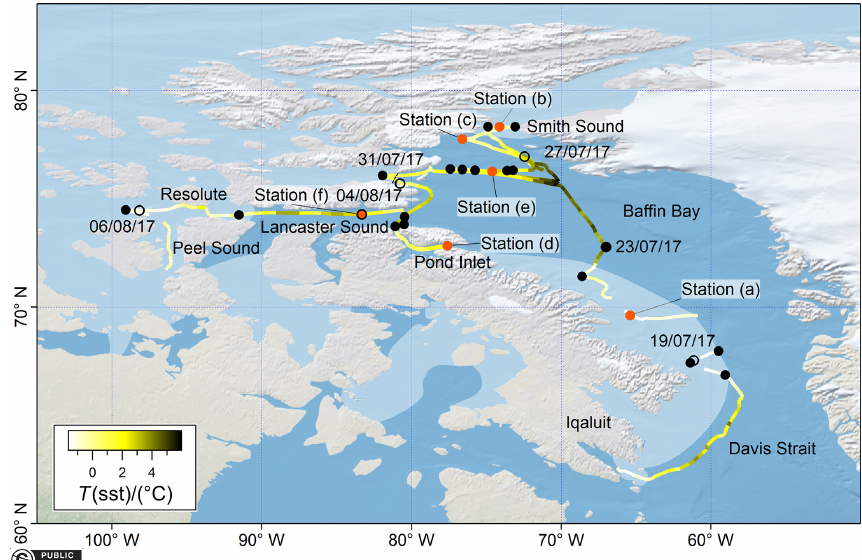
Figure 1. Cruise track of the sampling undertaken in the Arctic sea ice zone coloured by sea surface temperature (SST). Sampling dates are indicated as hollow circles marked with the date. The location of each CTD station where sampling was undertaken is indicated as a closed black dot. Highlighted CTD stations are indicated as closed orange dots and labelled by station number. Interruptions in the cruise track and underway auxiliary data are due to interruptions in the ship underway logging system (Amundsen Science Data Collection, 2017). All the map data were created from public domain GIS data found on the Natural Earth website (http://www.naturalearthdata.com, last access: 15 April 2021). They were read into Igor using the Igor GIS XOP beta. The sea-ice-covered area is approximately indicated for illustration purposes as a shaded area due to the dynamic nature of sea ice and difficulties in conveying this information for a month-long deployment. The approximate location of the sea ice edge is based on the average sea ice concentration for the whole cruise duration using AMSR2 satellite data. Details on the sea ice concentration data used for analysis can be found in the text (Sect.